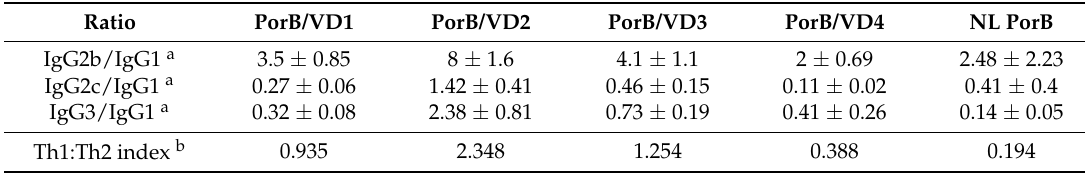
Figure 6. PorB/VDs are immunogenic. ( A ) Total serum IgGs measured by ELISA in sera from mice immunized with NL PorB or PorB/VDs plus CpG DNA and Montanide ISA 720 as adjuvants. PorB/VD1: upward triangles; PorB/VD2: squares; PorB/VD3: downward triangles; PorB/VD4: diamonds; NL PorB: circles. Pre-immune (Pr) and immune sera (week 2, week 4 and week 6) from individual mice in each group were tested in duplicate wells and are expressed as µg/mL ± SEM. ≈ p < 0.0001 by two-way ANOVA with Tukey’s multiple comparisons test; ( B–F ) IgG subclasses (µg/mL ± SEM) measured as above. ≈ p < 0.0003 by one-way ANOVA with Tukey’s multiple comparisons test. *; **; *** p < 0.05 by Mann-Whitney test. Table 1. IgG subclasses ratio (µg/mL ± SEM).